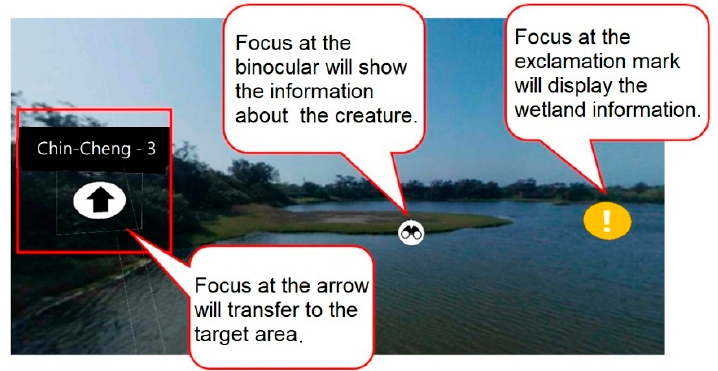
Figure 8. The icons for wetland or creature information and scene transfer.